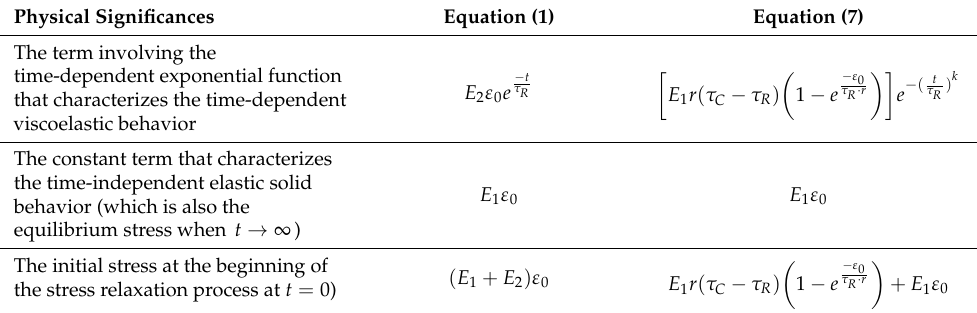
Table 2. Physical significances of our proposed constitutive equations derived with finite loading rate, i.e., Equation (7), and the traditional equations derived with infinite loading rate, i.e., Equation (1), for stress relaxation.